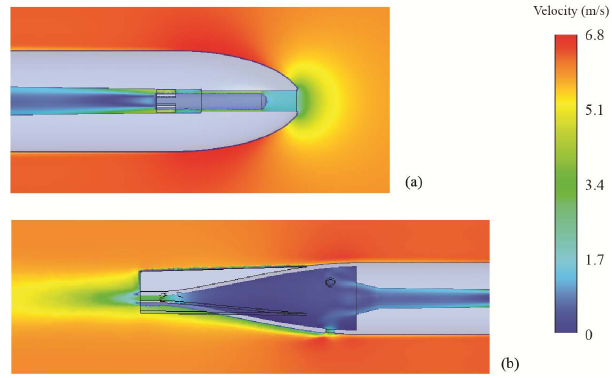
Fig. 2 – Velocity contours (a) at the leading edge of the probe and (b) in the aft region Fig. 2. Velocity contours (a) at the leading edge of the probe and (b) in the aft